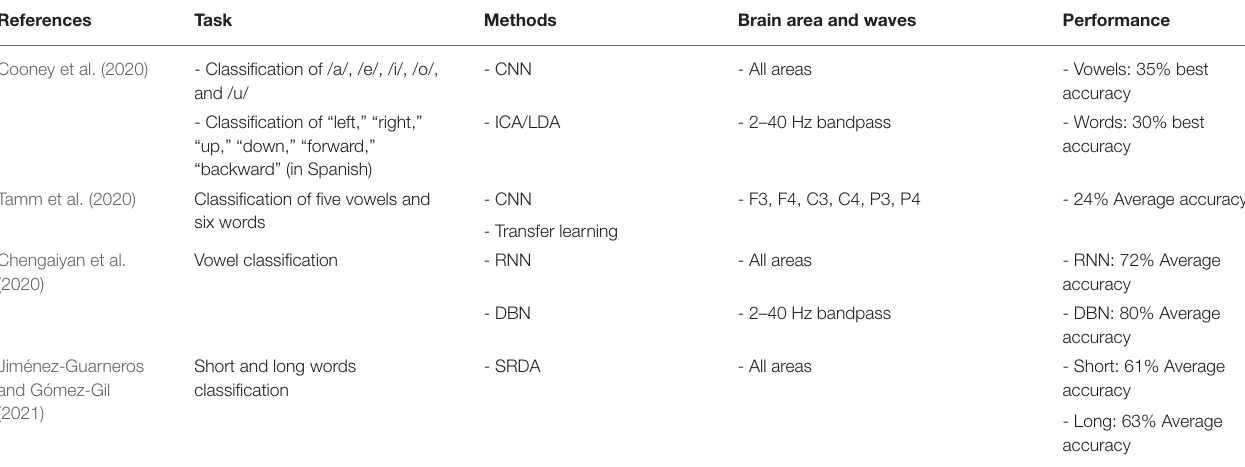
TABLE 6 | Imagined speech classification methods summary